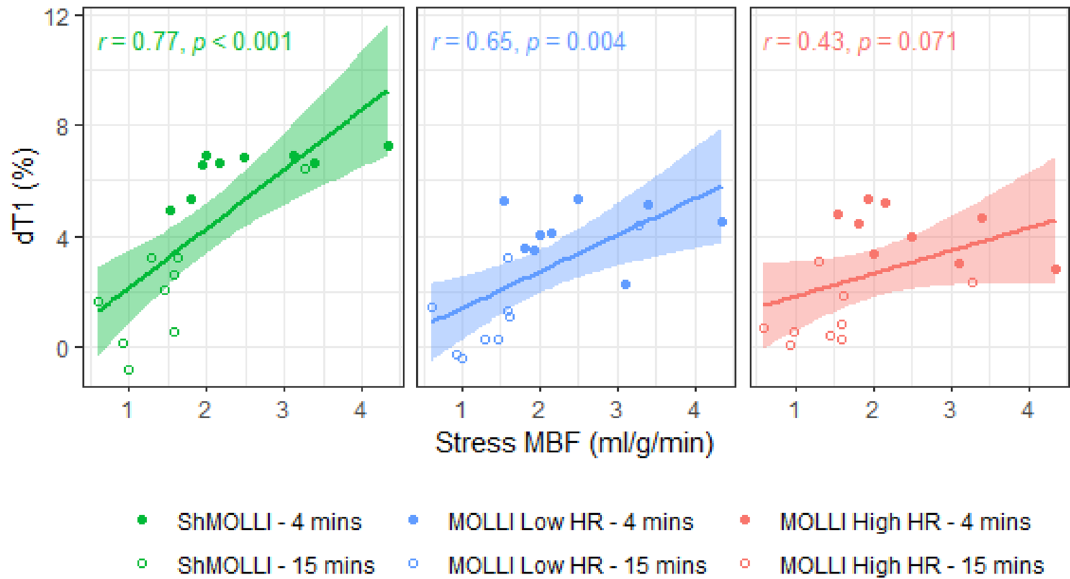
Figure 4. Correlation between stress MBF and dT1 during regadenoson stress. Stress MBF measured at ~ 4 (early stress) and ~ 15 min (late stress) after regadenoson in the same individuals on two separate days. Comparisons between dT1 and stress MBF are made for measured dT1 at the time point closest to MBF (all stress T1 data points measured within 90 s prior to MBF acquisition). Confidence intervals for the linear regressions are included (shaded ranges).